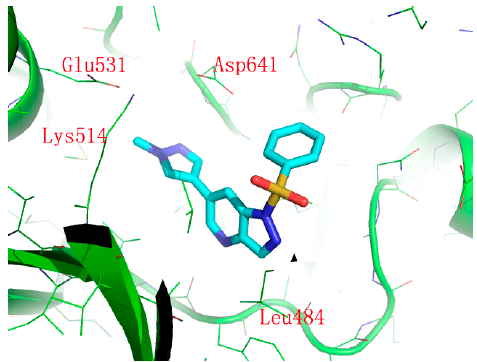
Figure 2. The docking study of compound 4 in FGFR1 binding site. The protein structure was extracted from the crystal structure (PDB code: 3TT0) and is shown in green, while compound 4 was depicted with a stick model and in cyan. Table 1. Structures and FGFR1 enzymatic activities of compounds 4 – 7 a . Compound No.